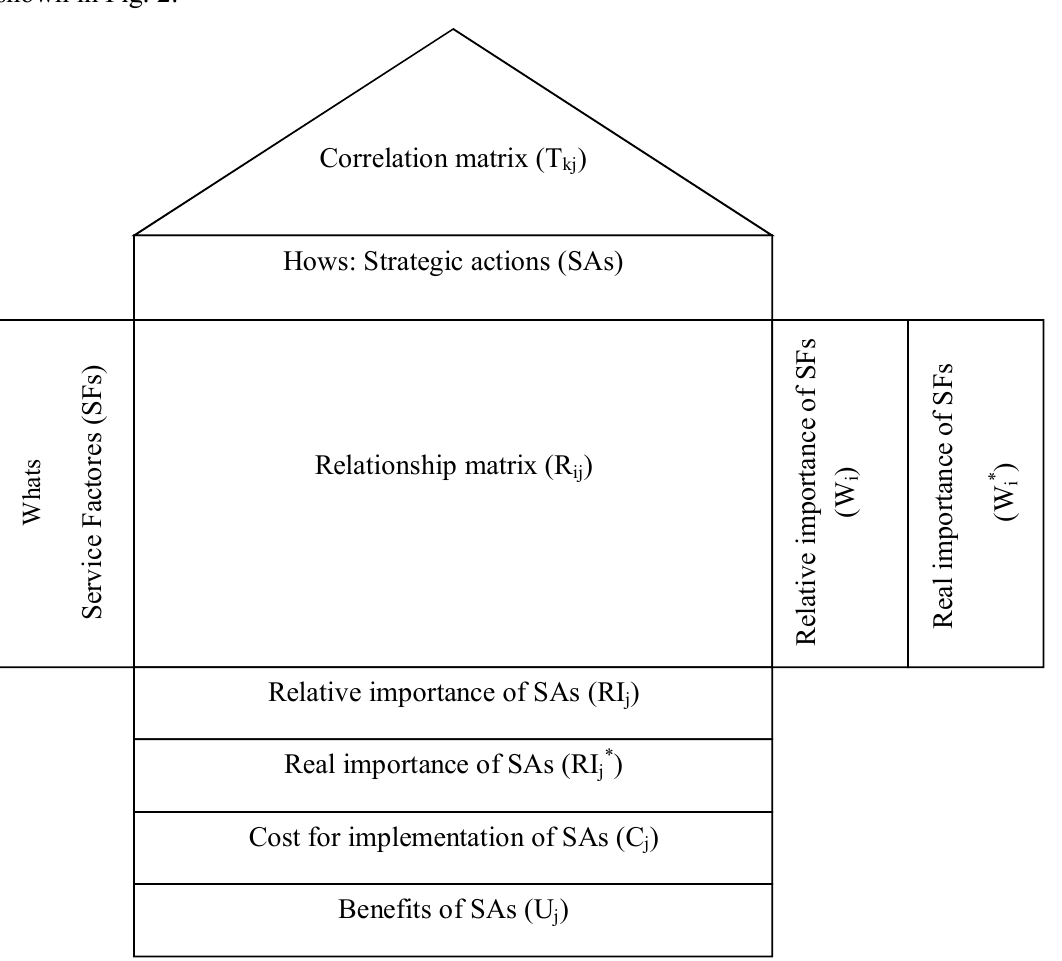
Fig. 2. The house of quality for the strategic management of logistics service (Bottani & Rizzi, 2005)